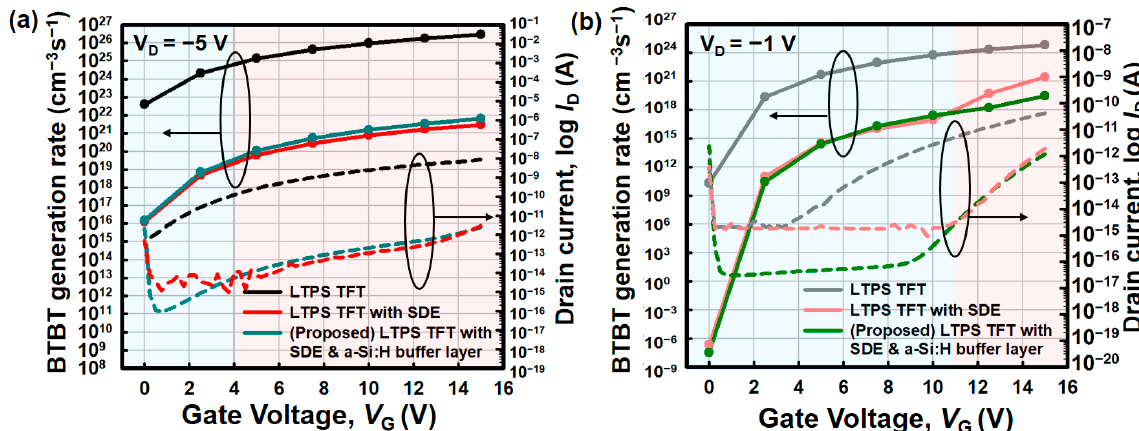
Figure 6. BTBT generation rate (left Y -axis) and off-state I D (right Y -axis) of a conventional LTPS TFT, LTPS TFT with SDE, and our proposed LTPS TFT: ( a ) at V D = − 5 V; and ( b ) at V D = − 1 V.